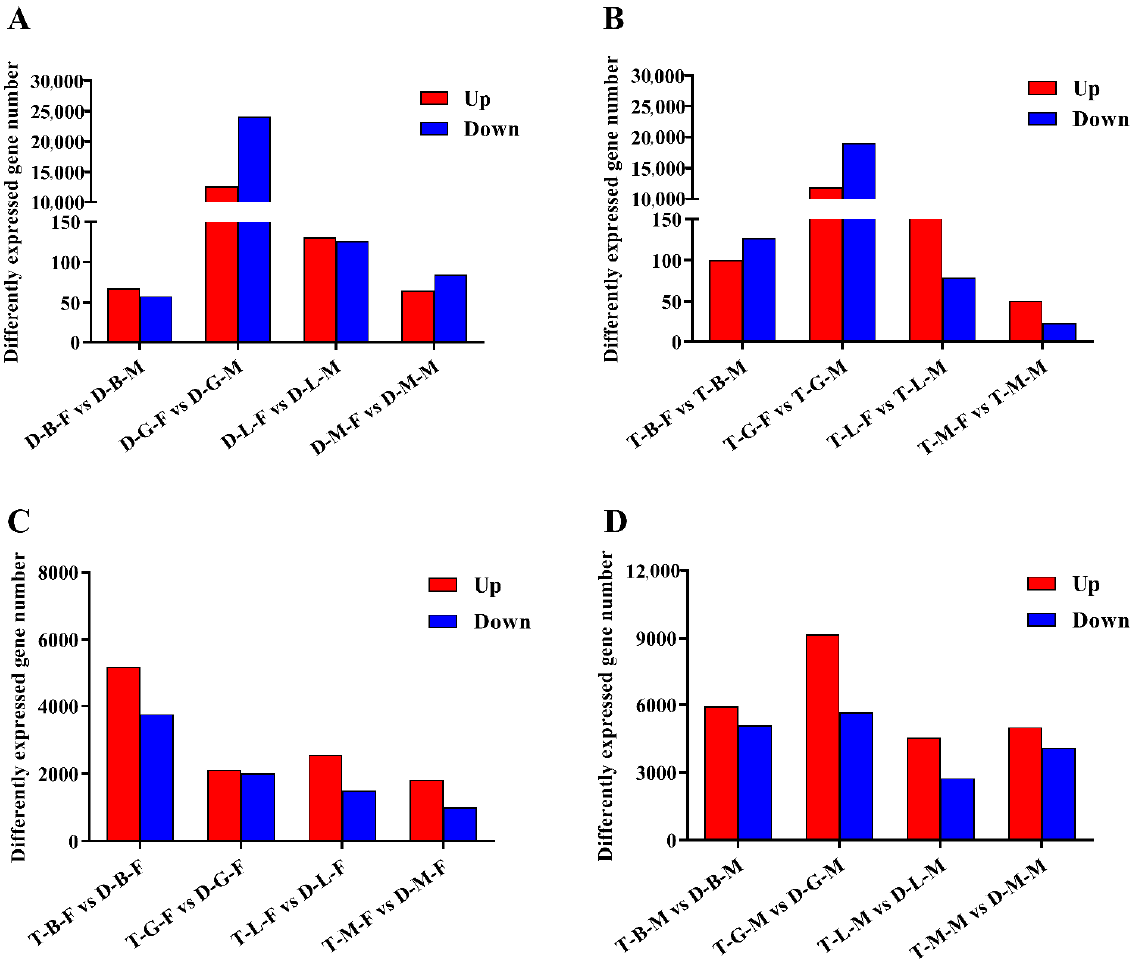
Figure 3. The number of DEGs in four tissues identified in the comparisons of: ( A ) diploid females and diploid males; ( B ) tetraploid females and tetraploid males; ( C ) tetraploid females and diploid females; and ( D ) tetraploid males and diploid males. The letters B, G, L, and M in the middle of each group represent brain, gonad, liver, and muscle, respectively.